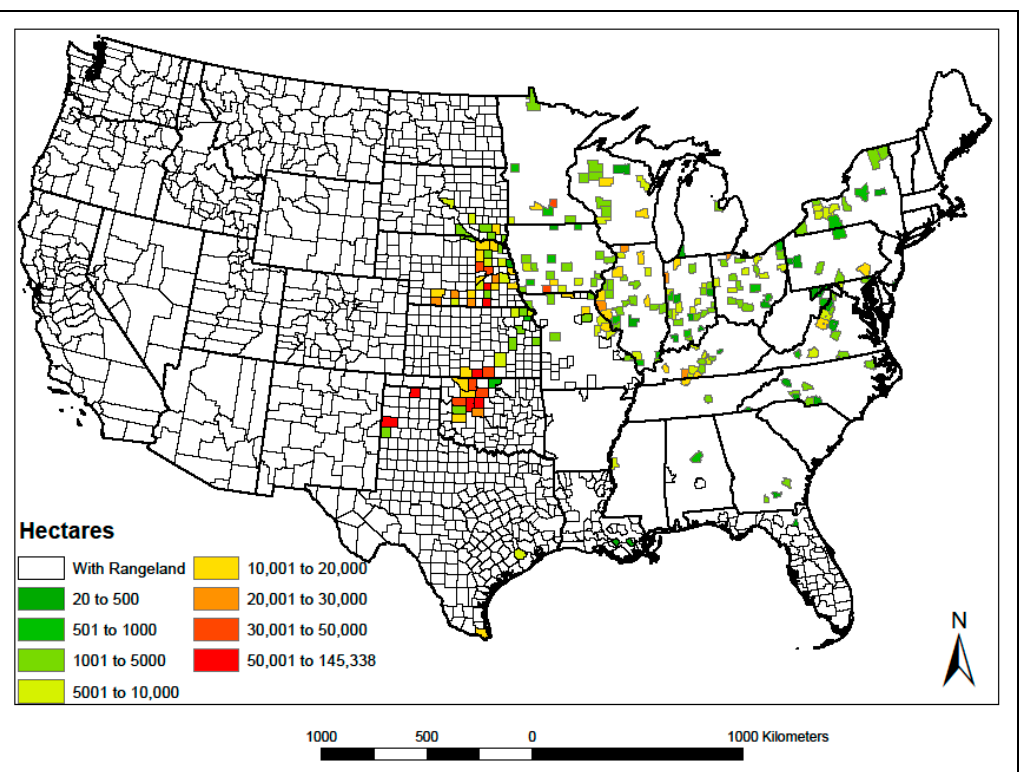
Figure 8. Counties with Rangeland and Increasing Cropland. Map by author.